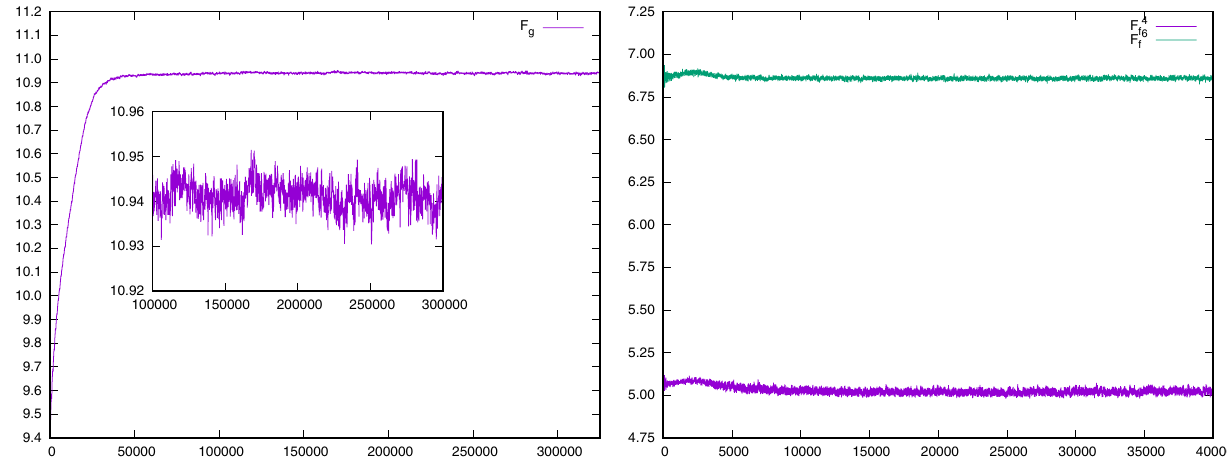
playedontheright.Notethatweareemployingamulti-levelintegration scheme with a relative factor among fermionic and gauge forces of